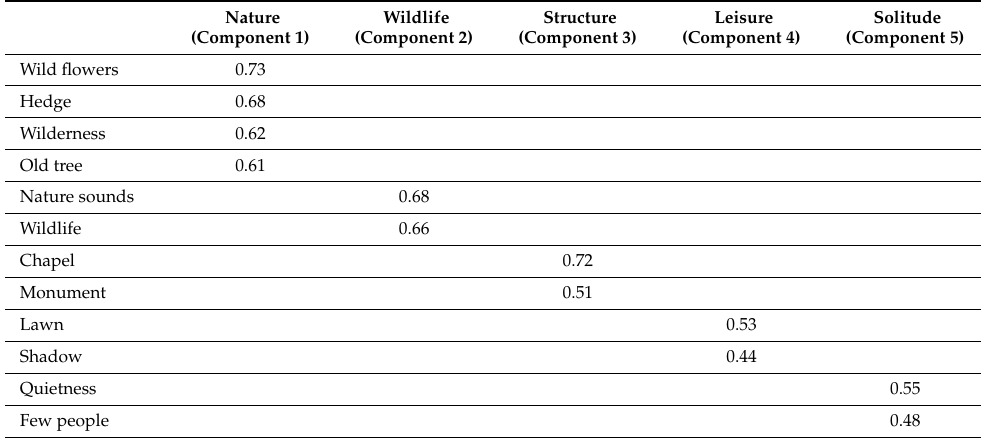
Table A1. Overarching cemetery features that were derived from an exploratory factor analysis (EFA) with varimax rotation. The standardized loadings (pattern matrix) are based upon correlation